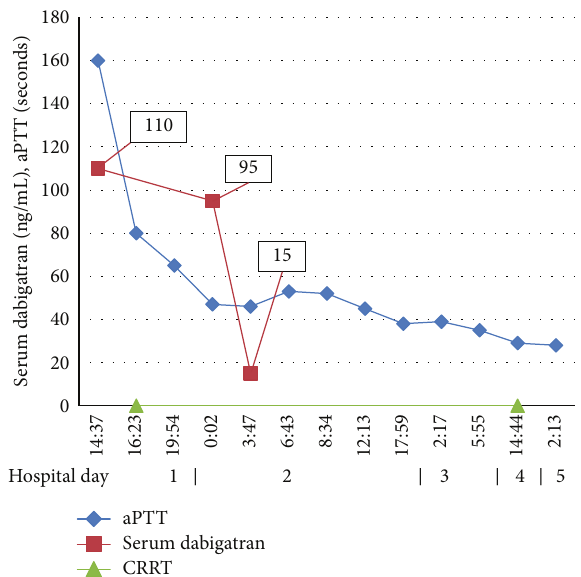
Figure 1: Serum dabigatran levels and aPTT trend over